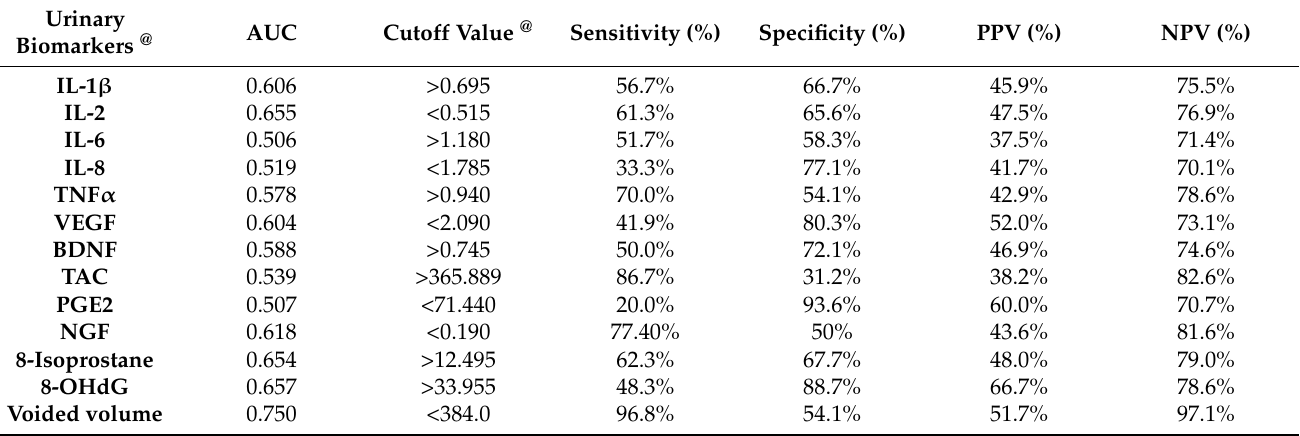
Table 4. Diagnostic values of urinary biomarkers and voided volume between the USI and DO and non-DO groups (USI and HSB and control groups).